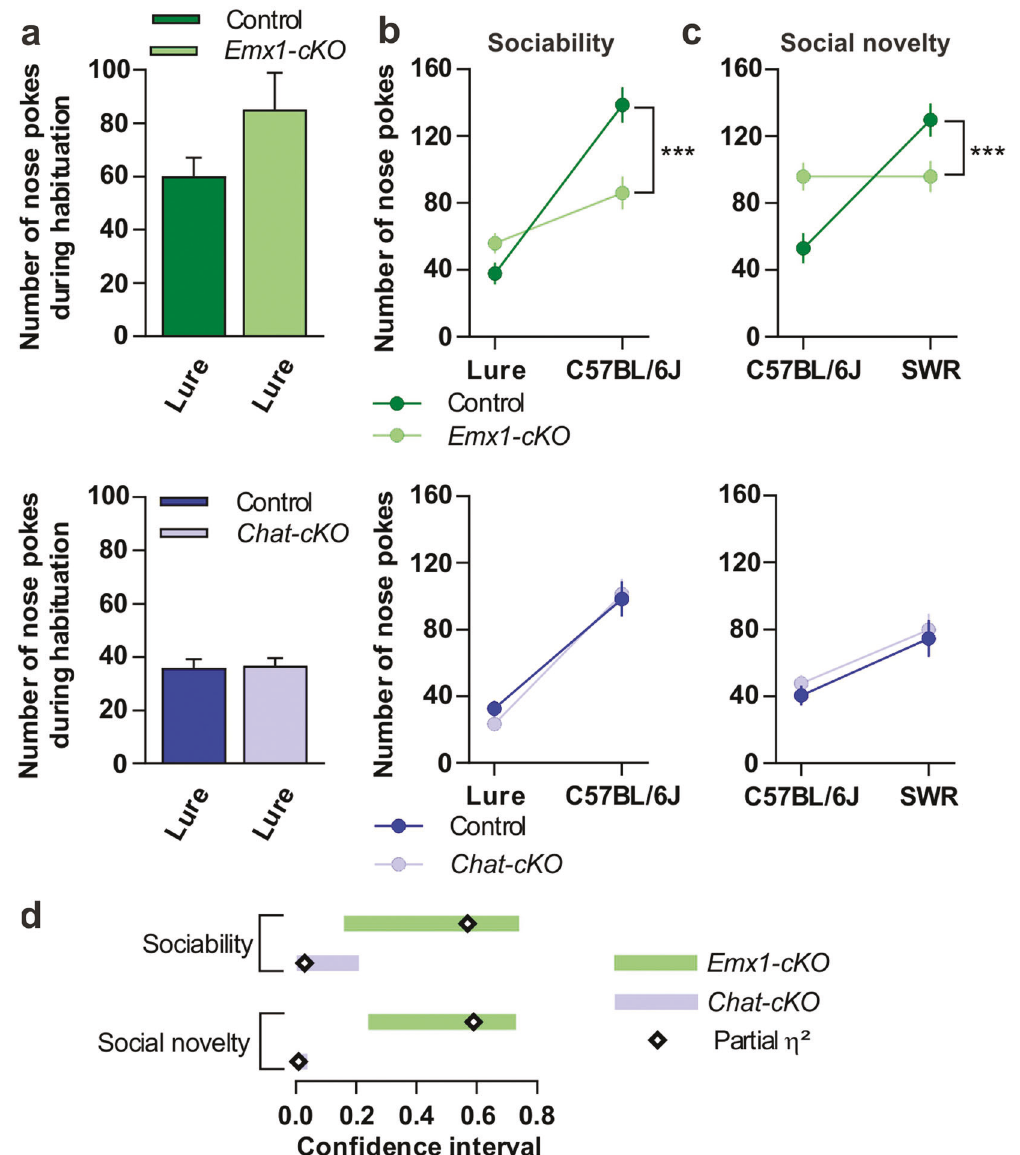
Fig. 5 Sociability and social novelty de fi cits in Emx1-cKO but not in Chat-cKO mice. a Nose pokes during habituation, used as covariate for mixed-design ANCOVAs in ( b ) and ( c ). b Sociability measured as the number of nose pokes against a C57BL/6J male mouse or a lure. Emx1-cKO mice ( n = 9) vs. control ( n = 8): F interaction (1,14) = 18.59, P < 0.001. Chat-cKO mice ( n = 12) vs. control ( n = 9): F interaction (1,18) = 0.55, P = 0.47. c Interest in social novelty measured as the number of nose pokes against the same C57BL/6J or a SWR mouse. Emx1-cKO vs. control: F interaction (1,14) = 19.70, P < 0.001. Chat-cKO vs. control: F interaction (1,18) = 0.02, P = 0.89. d Sizes of the difference for Emx1-cKO (partial η 2 = 0.57 and 0.59 for ( b ) and ( c ), respectively) and Chat-cKO mice (partial η 2 = 0.03 and 0.001, respectively) vs. their respective control. Data in ( a – c ) are expressed as means ± SEM. *** P <